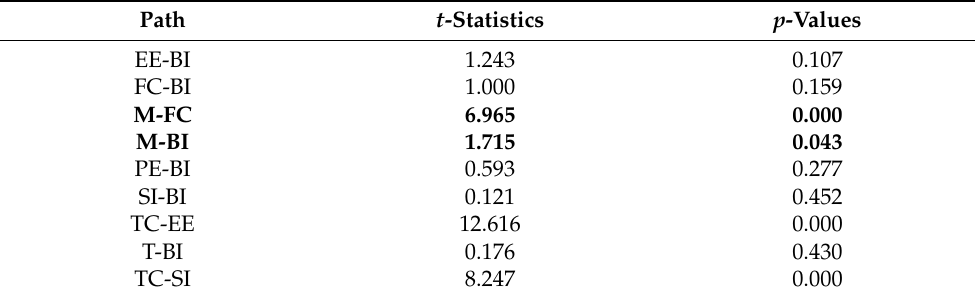
Table 3. Structural model results (bold rows highlight significant paths).